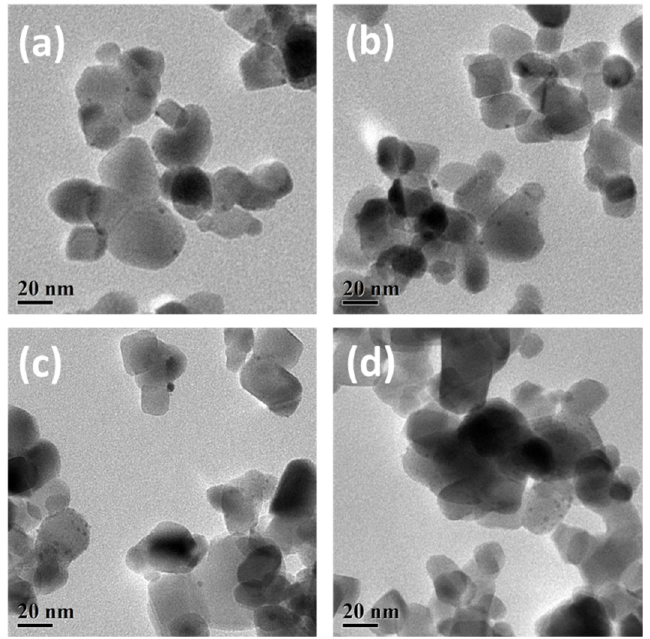
Figure 6. TEM images and the associated particle size histograms of the Au/TiO 2 samples activated by ( a ) pure Ar, ( b ) 10% O 2 /Ar, ( c ) 30% O 2 /Ar and ( d ) 50% O 2 /Ar plasmas.